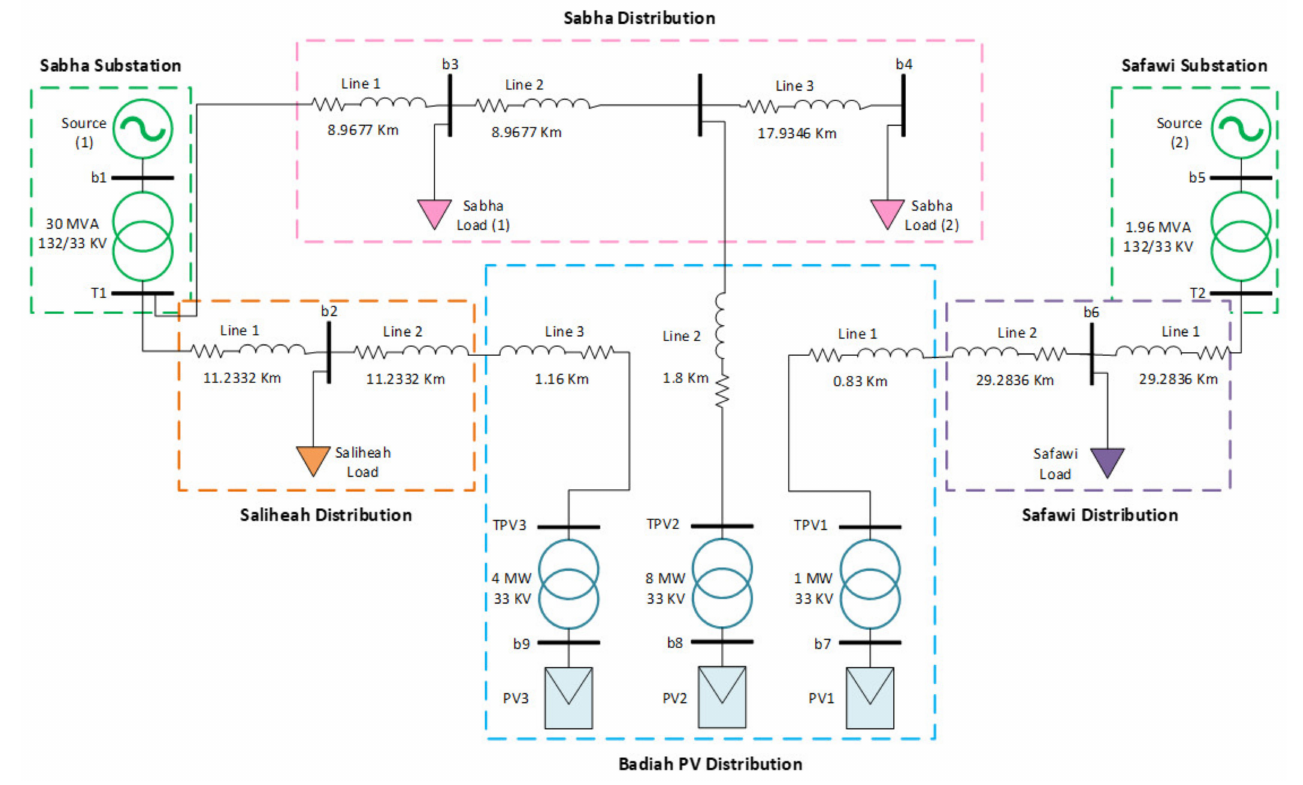
Figure 1. Single-line diagram of JSDN Simulink mode. Table 5. Load flow calculations for JSDN, Obtained by